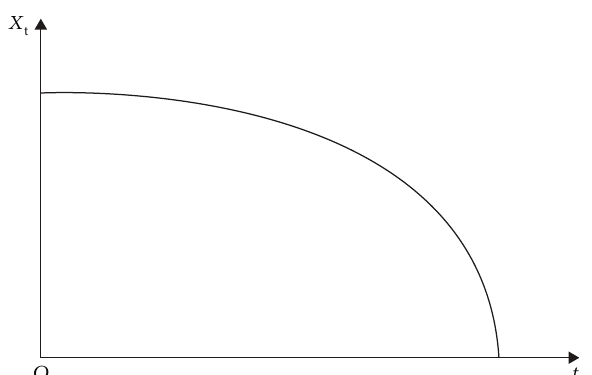
Figure 1: Curve representing decomposition of organic matter in litter.